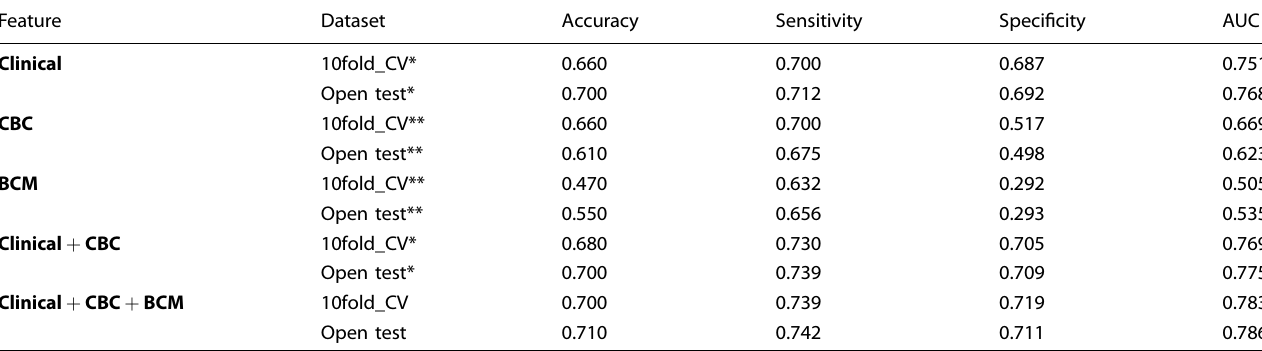
Table 5. Classi fi cation performance of XGBoost using clinical features, hematologic biomarkers and their combination, for samples of disease duration >3